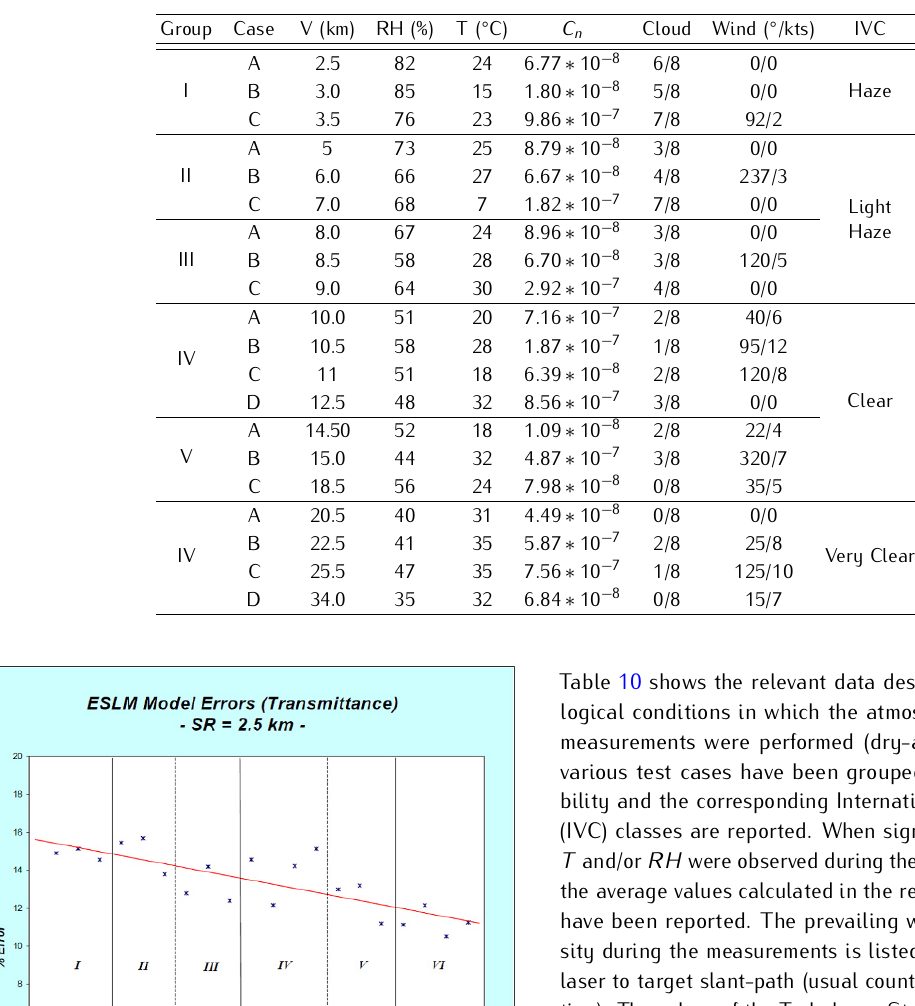
Table 10. Meteorological data for dry-air propagation measurements at λ = 1064 nm.